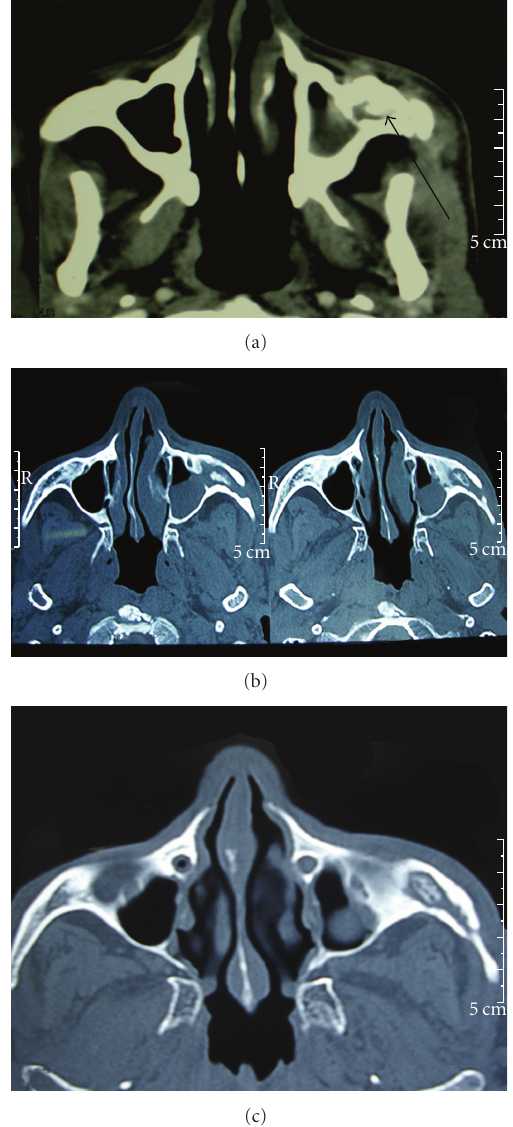
Figure 2: CT scan showing osteomyelitis of left maxilla and zy-